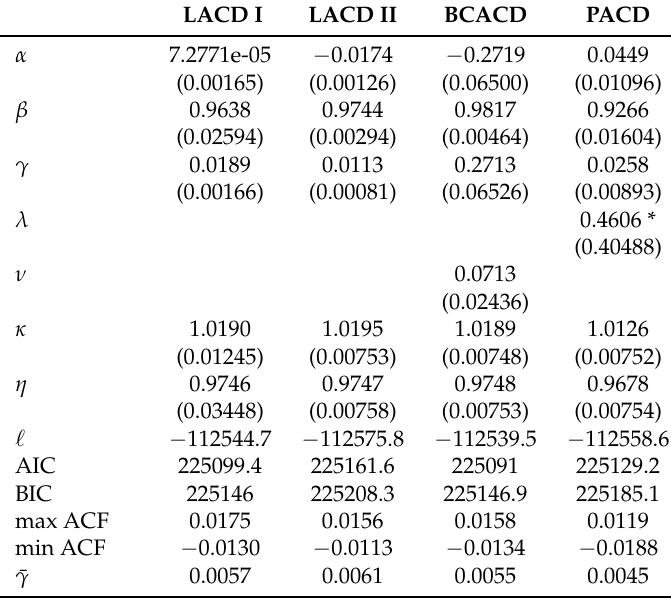
Table 7. Estimation results for ACD specifications of JNJ trade durations. A star ( parameter estimate is not significantly different from zero.